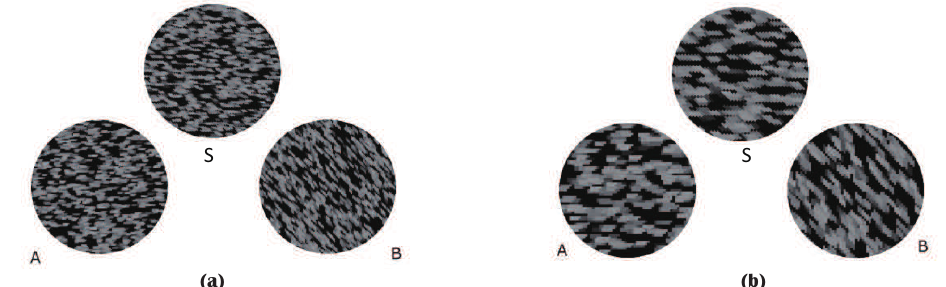
Figure 2. ( a ) Scene 1 and ( b ) Scene 2 (200% zoom of Scene 1) in the experiment. The locations of Textures A and B are randomly on the left or